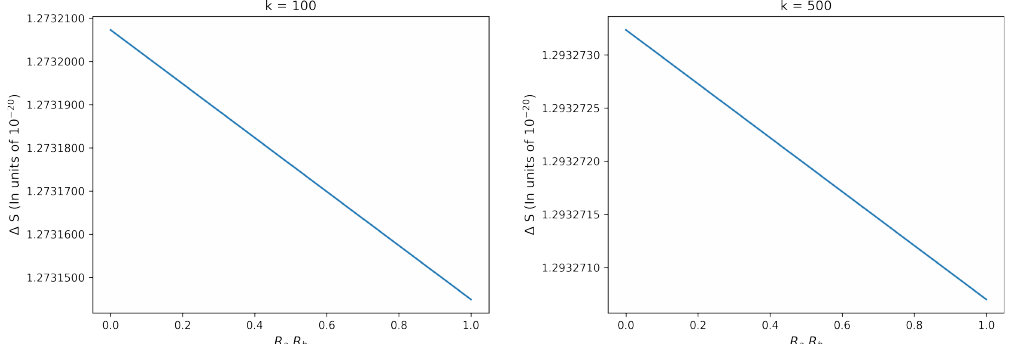
Figure 3 . The change of von Neumann entropy. We us the kinematics Gm 2 = 10 − 6 , bm = 1000 , = 100 , 500 . The change of von Neumann entropy decreases linearly as the charge to mass k = | ~p | m ratio